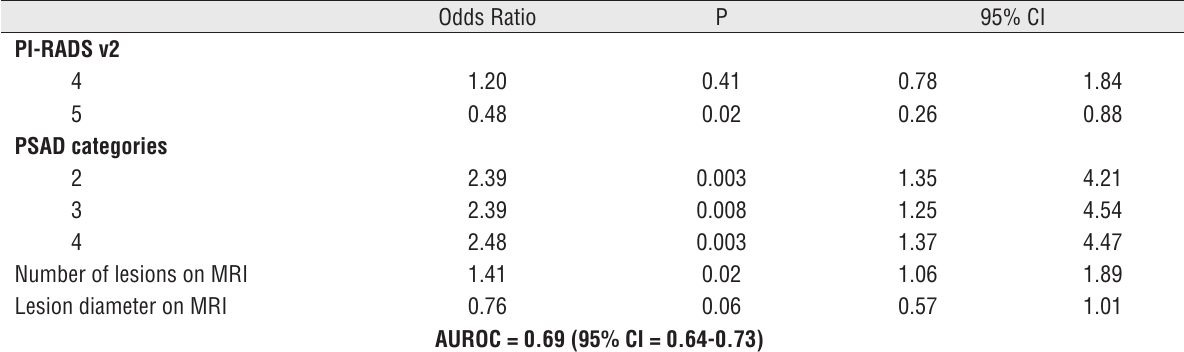
P = probability; CI = confi dence interval; PI-RADS v2 = Prostate Imaging Reporting and Data System, version 2; PSAD = prostate-specifi c antigen density; MRI = magnetic resonance imaging; AUROC = area under the receiver-operating characteristic